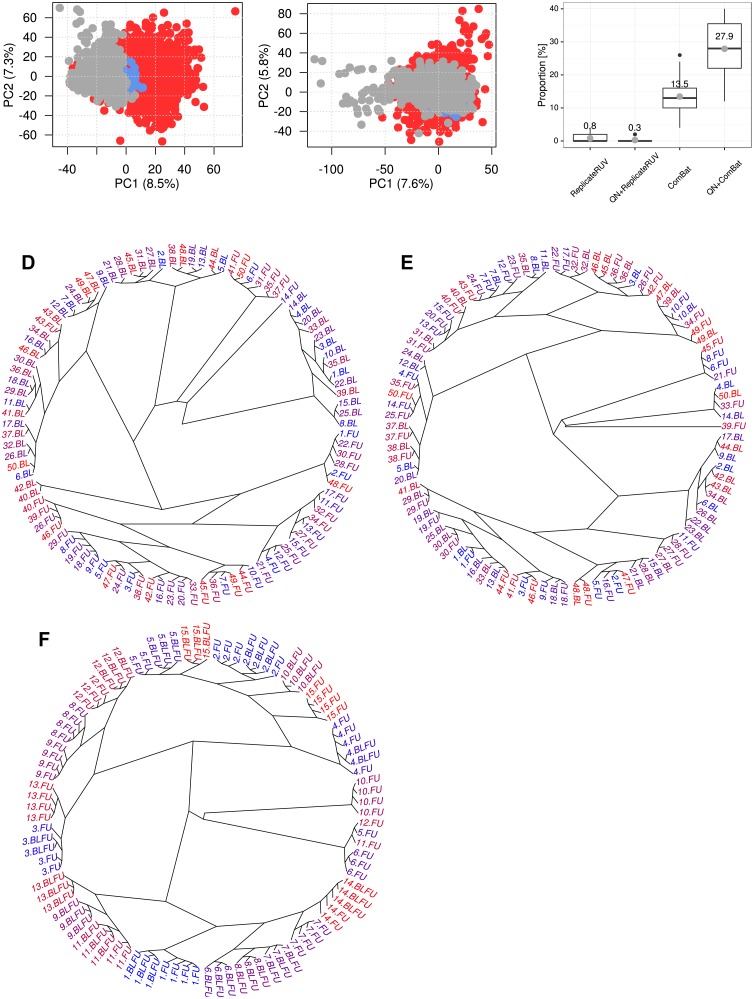
Comparison of batch effect removal by ReplicateRUV and ComBat in the full dataset.Overall gene expression was corrected for batch effects by either ReplicateRUV or ComBat. A, B: Components of variance are visualized as PCA plots. Samples extracted and measured at baseline (BL) are marked red, repeated measures at 5-year follow up (BLFUrep) in blue and follow-up (FU) samples in grey. Batch correction based on A: quantile normalization plus ReplicateRUV resulted in clusters indicating remaining batch effects, while B: quantile normalization plus ComBat removed those effects. C: 50 subjects with BL and FU gene expression data available were drawn from 1092 individuals in 22 iterations. Gene expression was hierarchically clustered and the number of subjects with BL and FU falling into direct proximity was counted. On the y-axis, the proportion of correctly clustered pairs is shown for different batch effect removal approaches. Quantile normalization plus ComBat led to the highest proportion of pairs indicating maintained intra-individual similarity between time points. D: Example dendrogram from hierarchical clustering after quantile normalization plus ReplicateRUV. Each individual is represented with an ID between 1 and 50. The labels BL and FU represent time points. One subject was identified with “BL” and “FU” (BL: Baseline, FU: 5y follow-up) clustered in direct proximity (40.BL, 40.FU). E: Clustering based on quantile normalized and ComBat corrected data led to 16 individuals with BL and FU in the same cluster. F: Hierarchical clustering of quantile normalized data for 15 subjects with BLFUrep and FUrep measurements. Here, for 7 individuals (46.7%) all measurements fell into the same cluster.